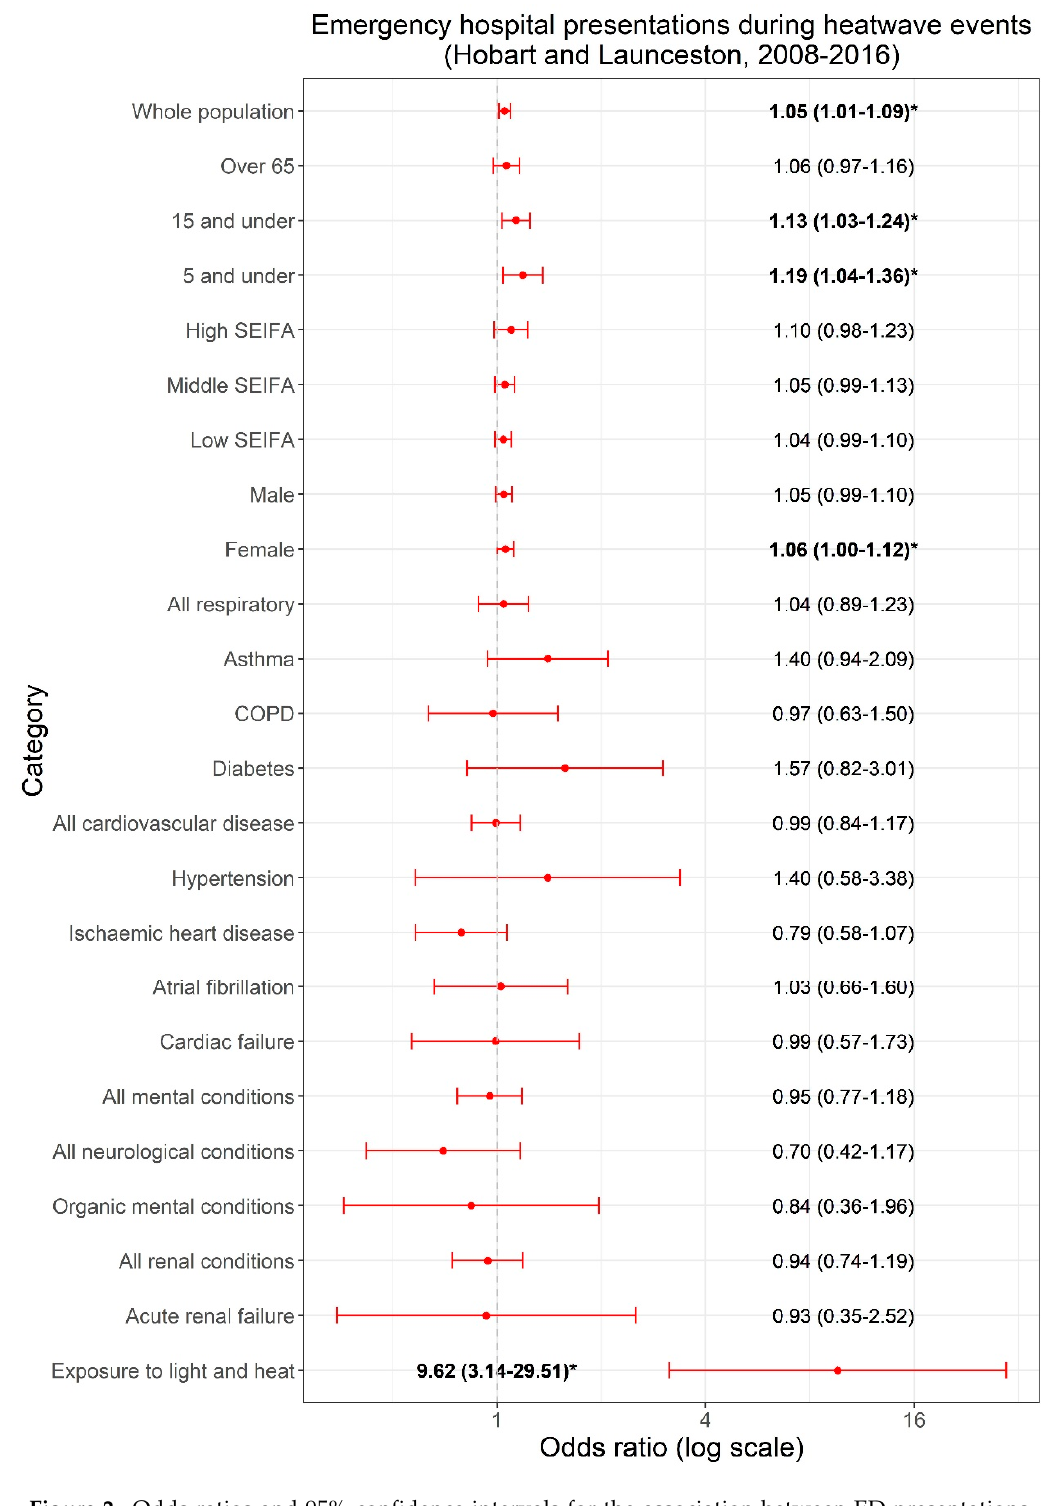
< 2.5 (* and bold indicates p